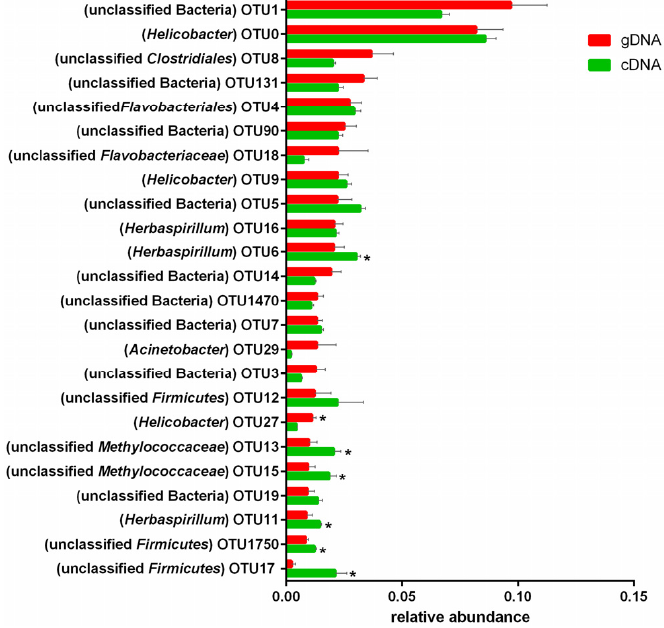
Figure 5. The relative abundance of top 20 ureC gene operational taxonomic units. In brackets represent bacteria genus. * p < 0.05.